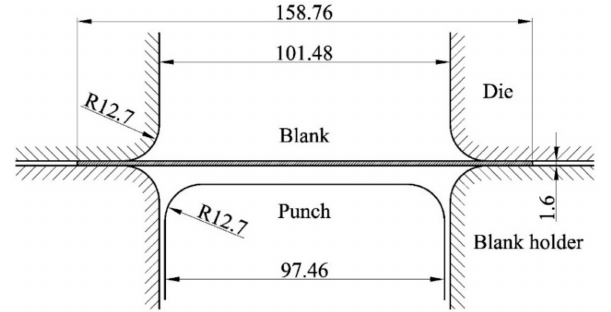
Figure 9. Schematic view of the deep drawing of a cylindrical cup (units in mm). The geometric parameters of the blank are: initial thickness